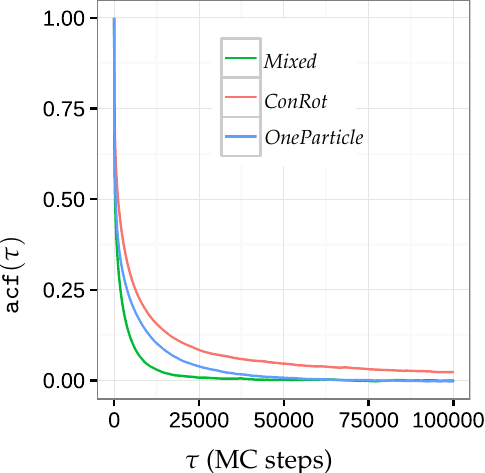
Figure 5. Plots of the average autocorrelation function over the 20 central dihedral angles of 14-alanine for the ConRot , OneParticle , and Mixed move classes. Table 3. Autocorrelation times τ int (in MC steps) of the ConRot , OneTorsion , and Mixed move classes.